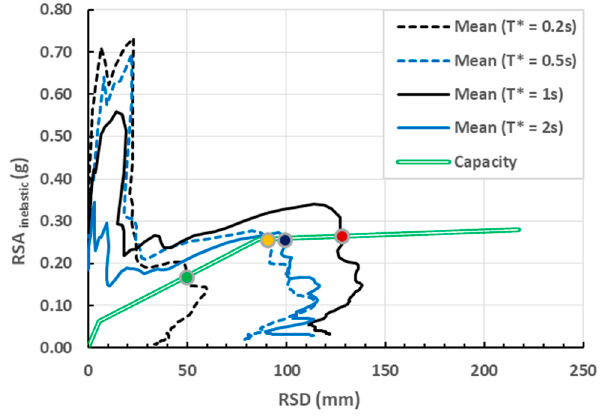
Figure 7. Superimposing of the mean inelastic ADRS demand and inelastic capacity curve.